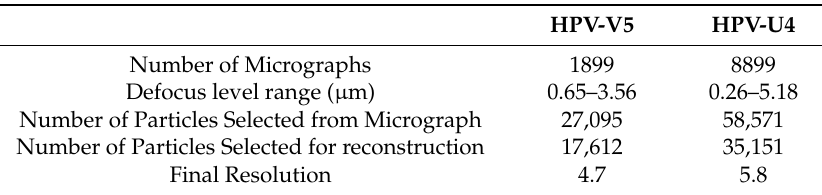
Table 1. Cryo-EM image reconstruction